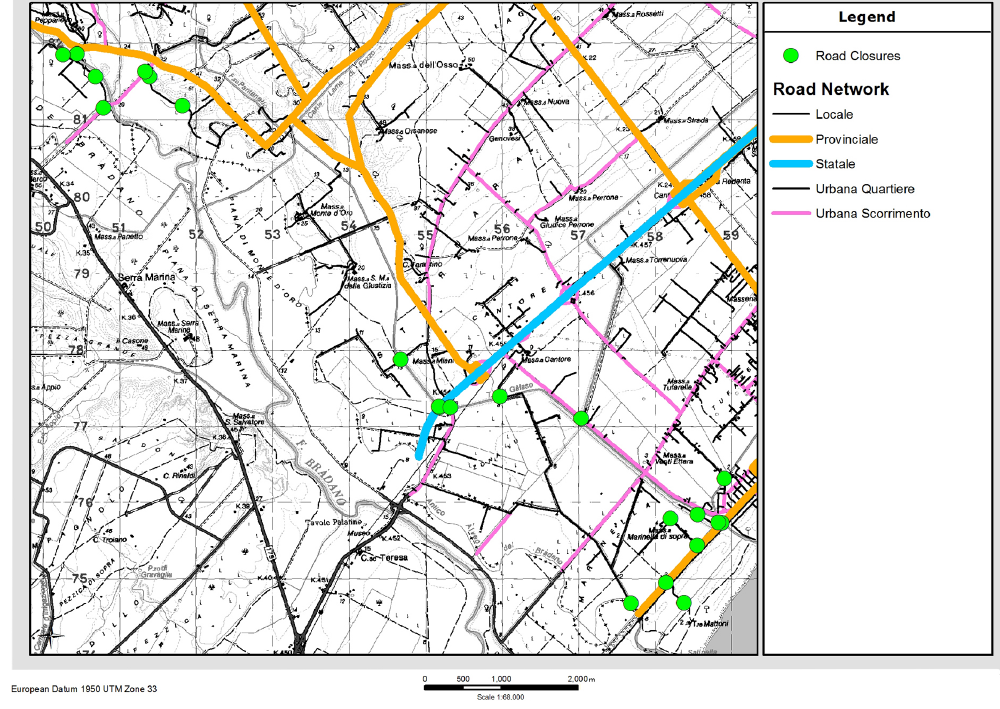
Figure 12. Road closures due the chosen scenario.